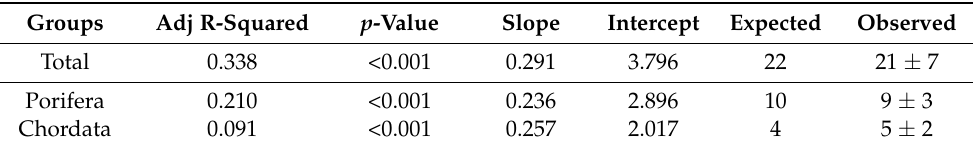
Figure 3. Linear regressions on log-transformed variables: Stot—total species; Scor—coralligenous species; Scon—constant species; Sfre—frequent species; Stem—temporary species; Scho—Chordata species; Smol—Mollusca species; Spor—Porifera species; Sses—sessile species; Svag—vagile species, A—sample size. Table 4. Adjusted R-squared, p -value, slope and intercept values of linear regression in Figure 3; number of species expected by Arrhenius model for a sample of 30 × 30 cm and average number of species observed in the 30 × 30 cm squares.